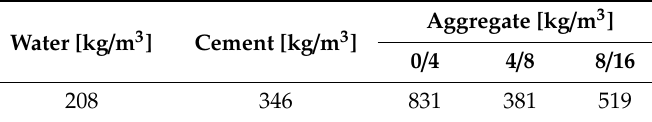
Table 3. Composition of concrete mixture.